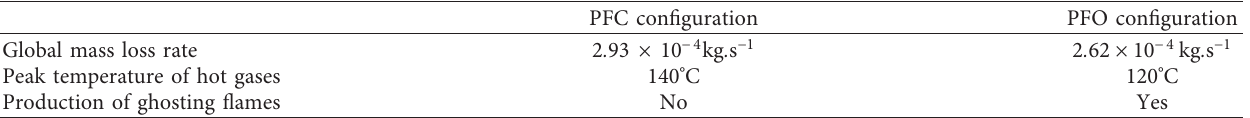
Figure 15: (a) Profiles of temperature in both configurations at time t � 5 seconds. (b) Profiles of temperature in both configurations at time t � 200 seconds. (c) Profiles of temperature in both configurations at time t � 250 seconds. (d) Profiles of temperature in both configurations at time t � 300 seconds. (e) Profiles of temperature in both configurations at time t � 400 seconds. (f) Profiles of temperature in both configurations at time t � 550 Table 3: Substantial differences observed between both compared fire tests.